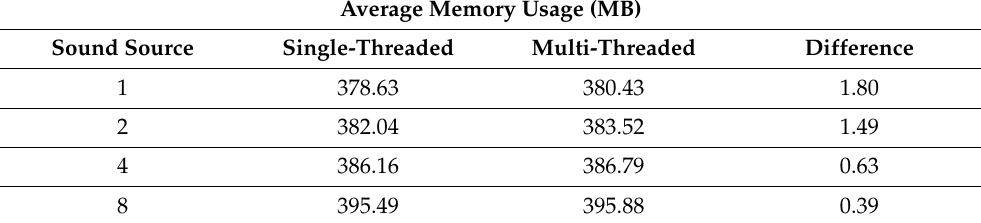
Table 4. Average memory usage comparison of single-threaded and multi-threaded algorithms in